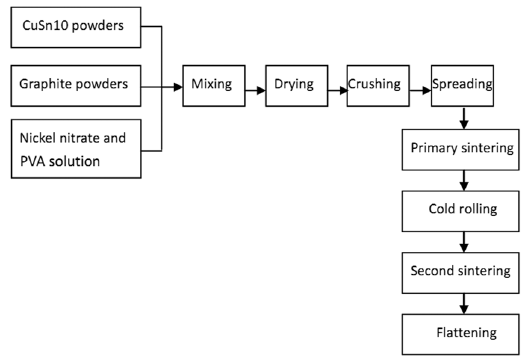
Figure 1: Flow diagram of preparation processes for graphite- CuSn10 composites containing Ni The solution of Ni(NO